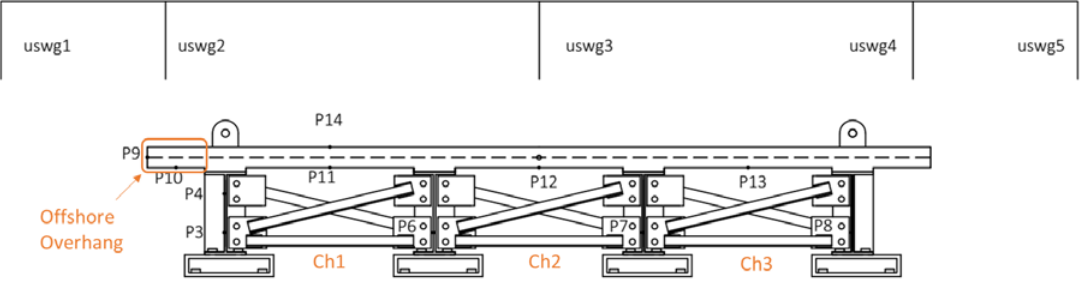
Figure 19. Schematic of bridge deck with location of pressure gages and ultrasonic wave gages.